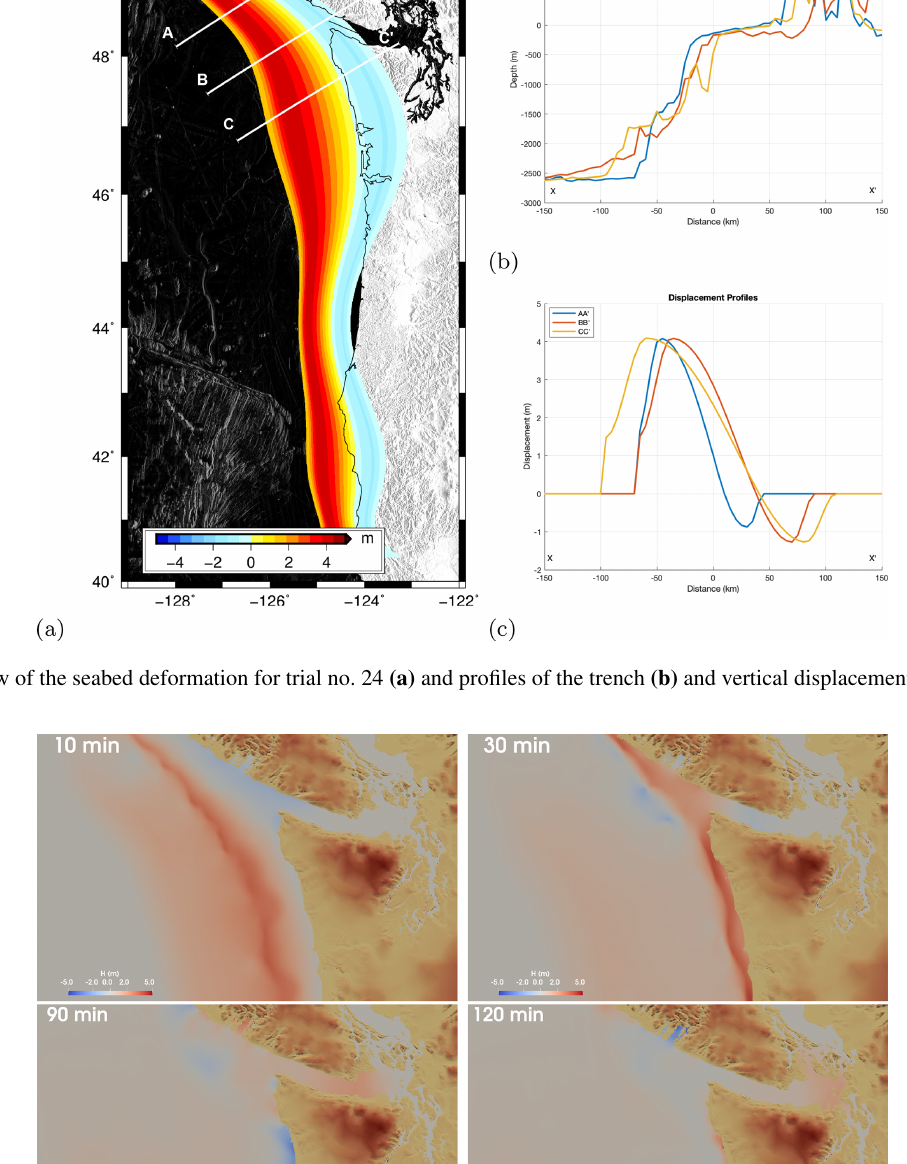
affected by these slight variations in the topography but more sensitive to the varying